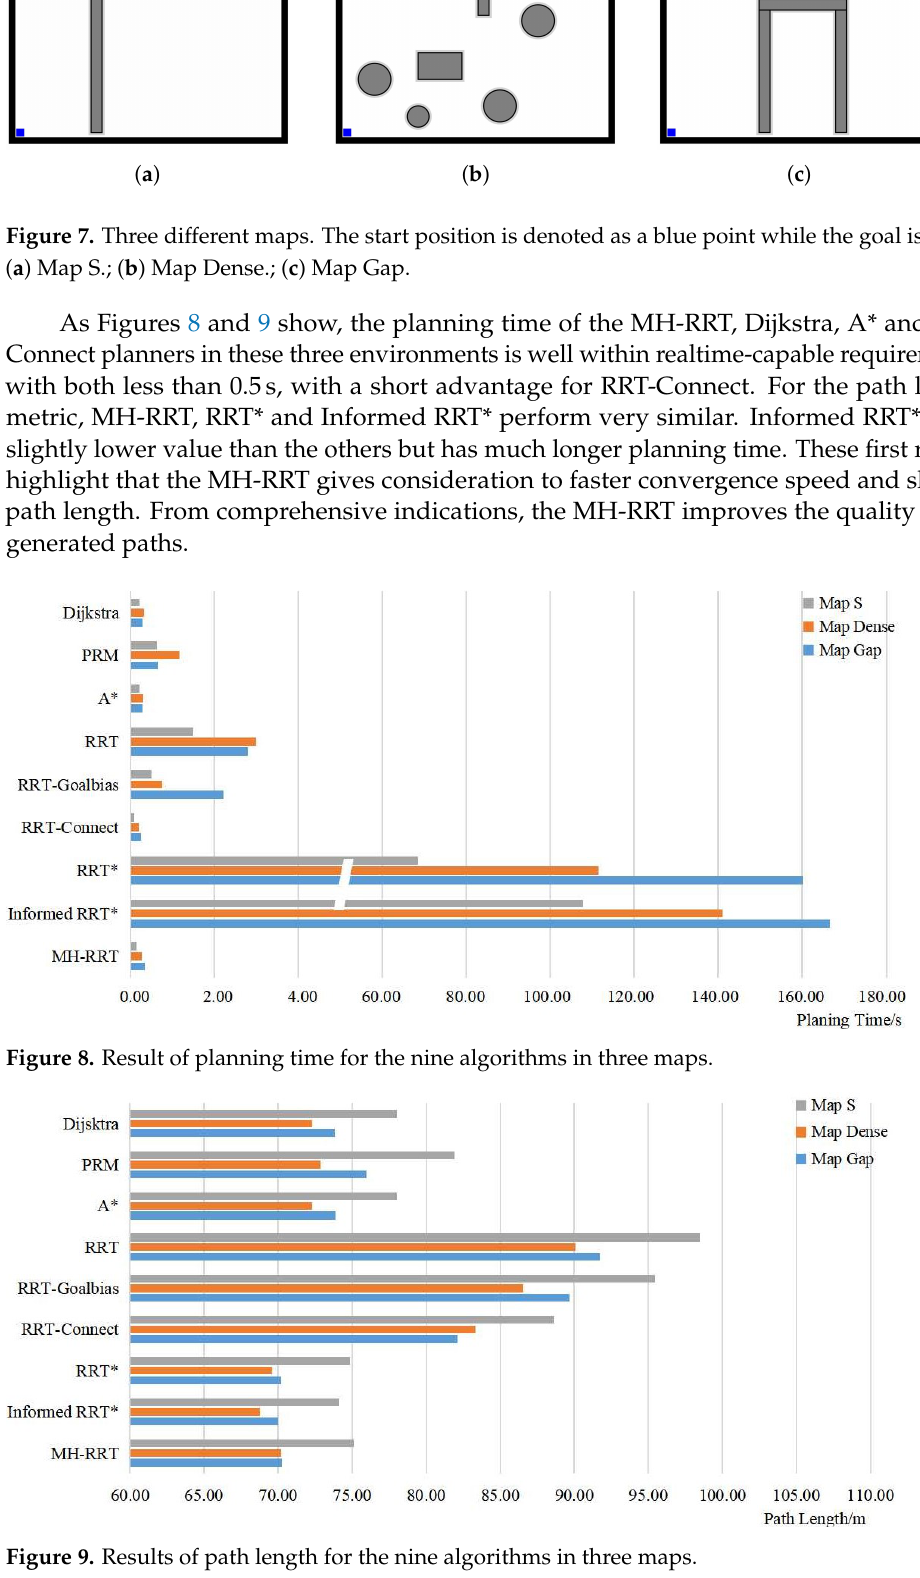
Figure 9. Results of path length for the nine algorithms in three